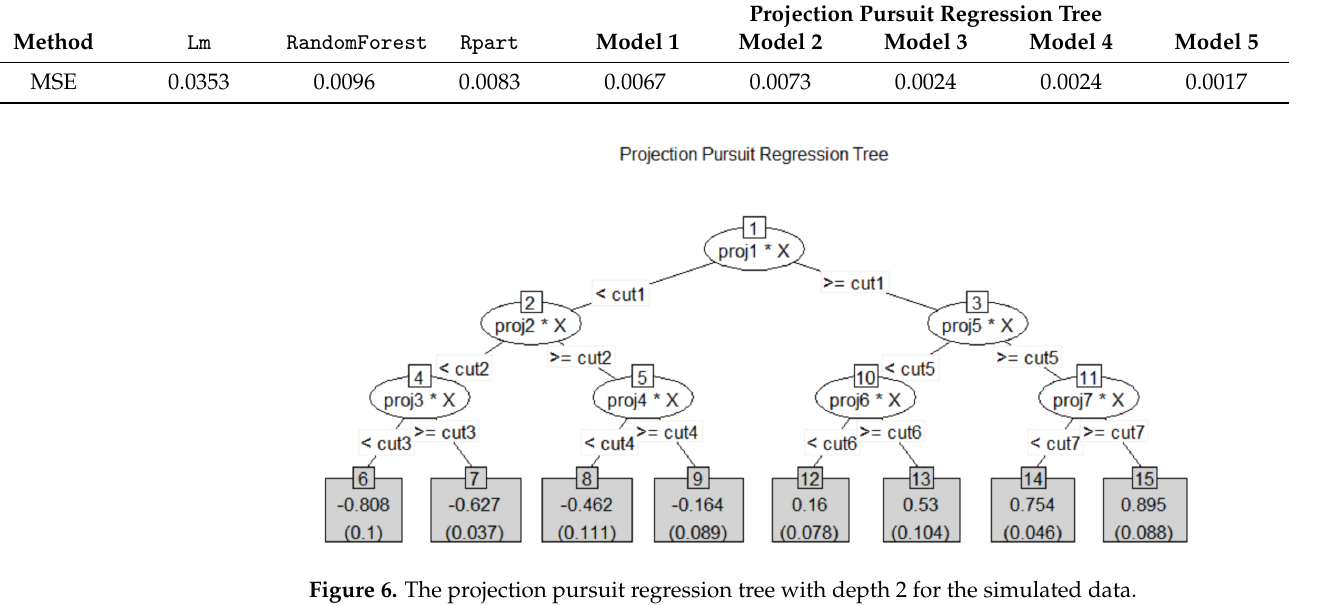
Figure 6. The projection pursuit regression tree with depth 2 for the simulated data.